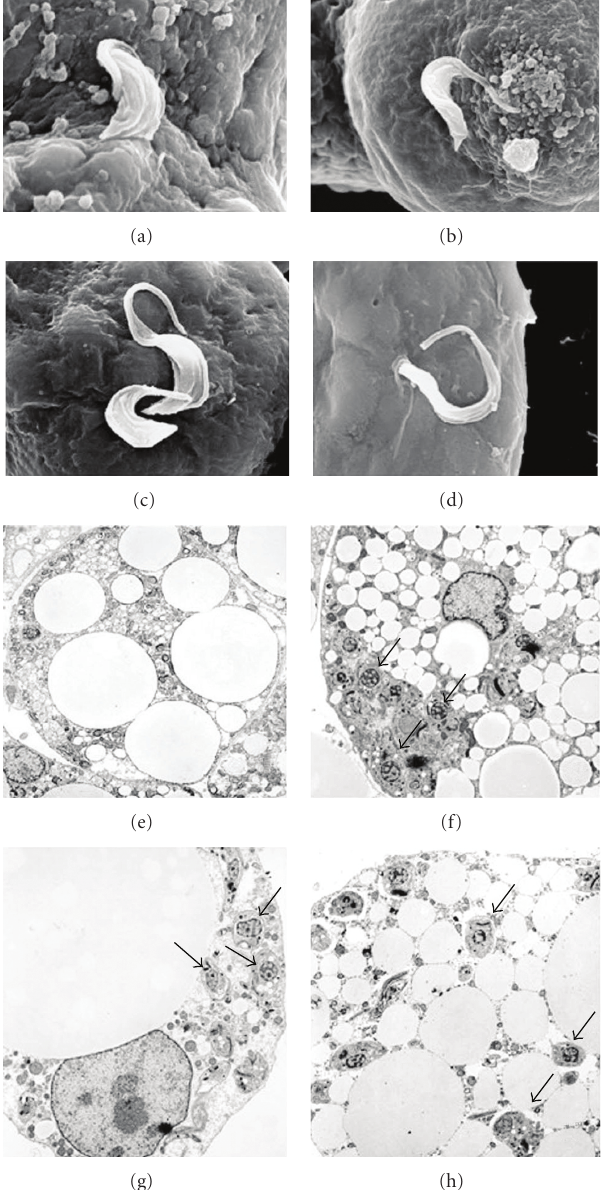
Figure 1: (a)–(d) Scanning electron micrograph of trypomastigotes of T. cruzi invading adipocyte. (e) A transmission electron micro- graph of an uninfected adipocyte. (f)–(h) Electron micrographs of infected adipocytes. The parasites (arrows) are in close proximity to the lipid droplets (with permission of the Journal of Biological